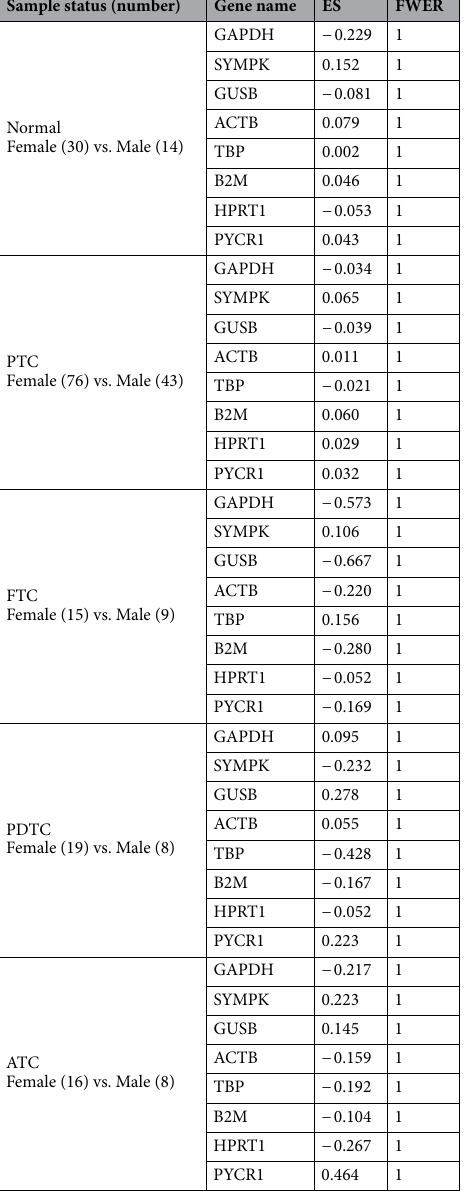
Table 4. Combined analysis of intra-subtype and inter-sex microarray data. The results of microarray analyses that combine intra-subtype and inter-sex data are presented. Female tissues were compared to male tissues in normal tissues, and TBP had the lowest ES value (0.002). The best reference genes in PTC and ATC tissues, are ACTB and B2M with effect sizes of 0.011 and − 0.104, respectively. With an ES value of − 0.052, HPRT1 was the best reference gene in both the FTC and the PDTC subtypes. ES effect size, FWER family-wise error